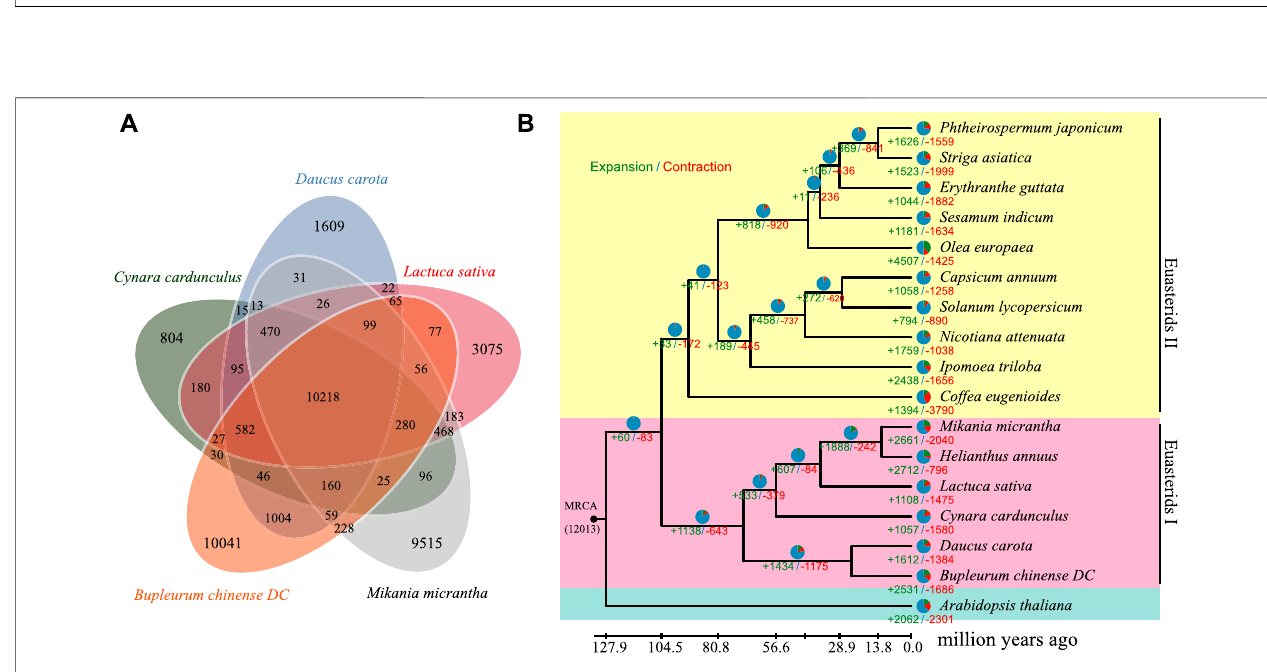
FIGURE 4 | Genome evolution analysis of B. chinense DC. (A) Venn diagram of the orthologous genes shared between Lactuca sativa , Cynara cardunculus , Mikania micrantha , Daucus carota , and Bupleurum chinense DC. (B) The phylogenetic relationship between B. chinense DC and 16 other species. The number of gene gains (+) and losses (-) is shown on each branch, and are also displayed as pie charts:green, red, and blue corresponding to gene gain, loss, and neither gain nor loss, respectively. The divergence times between the different species are displayed below the tree.